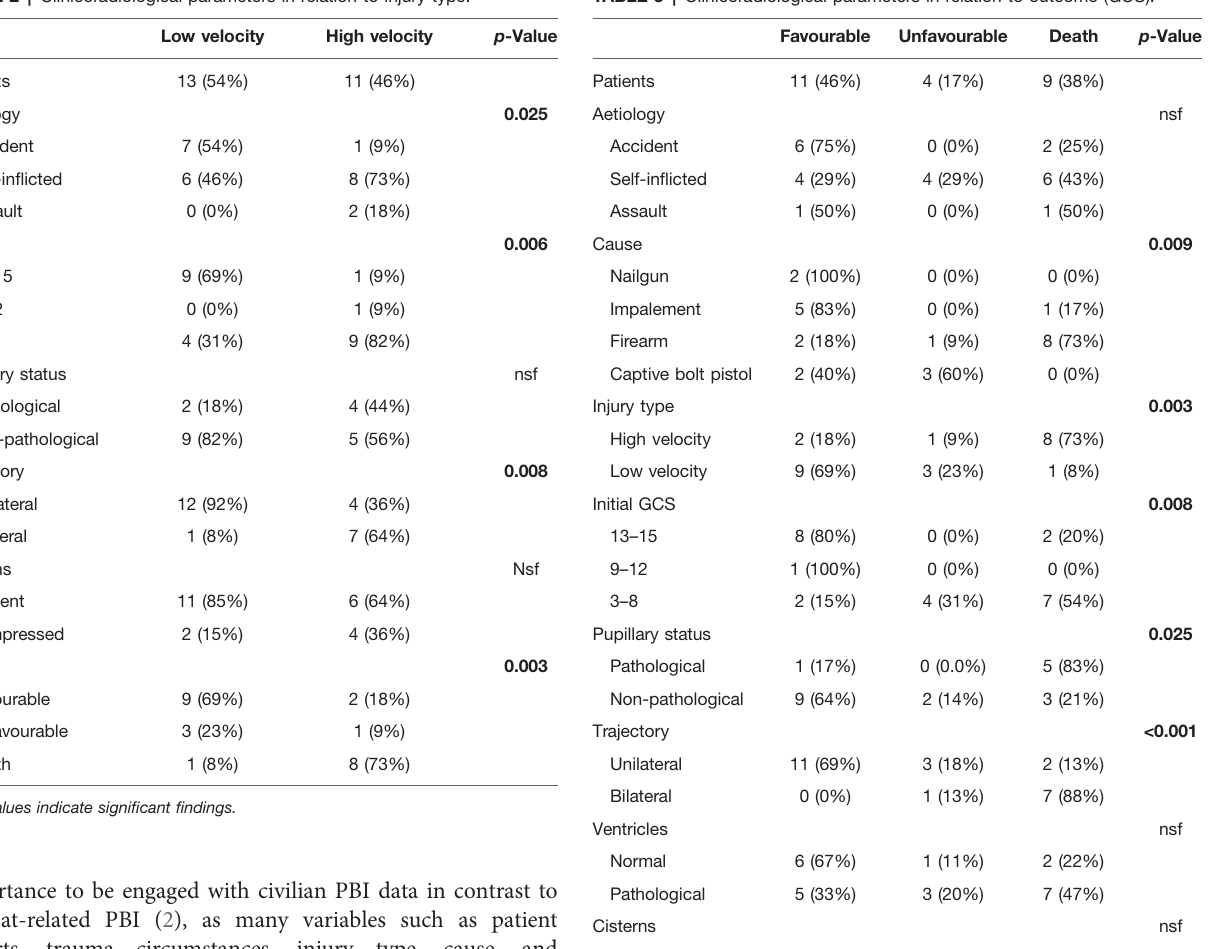
TABLE 2 | Clinicoradiological parameters in relation to injury type. TABLE 3 | Clinicoradiological parameters in relation to outcome (GOS).